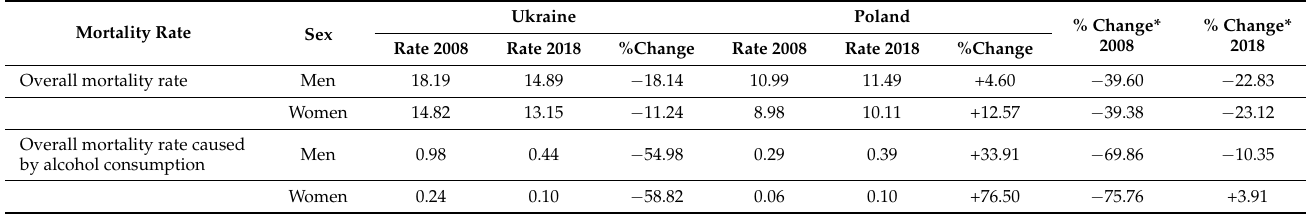
Table 4. Mortality rate of men and women due to alcohol